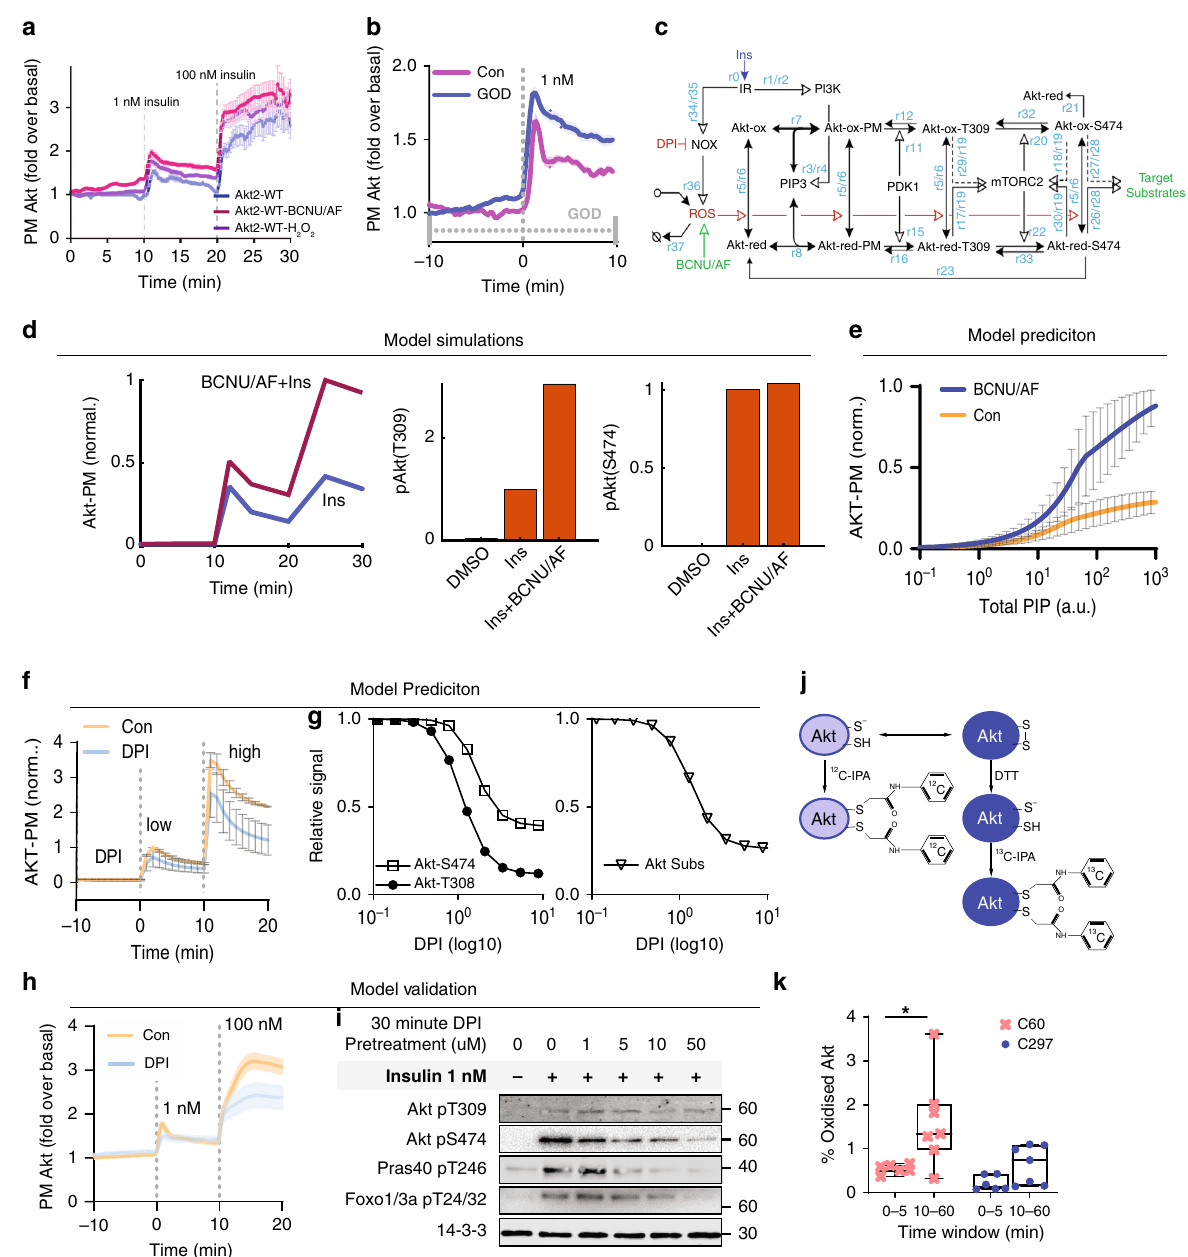
Fig. 7 A physiological role for C60 and C77. a , b TIRF imaging of adipocytes overexpressing TagRFPt-Akt2-WT treated with a BCNU/AF or H 2 O 2 (100 µ M) or b glucose oxidase (GOD) as indicated prior to stimulation with 1 nM insulin. Data are mean ± SEM. c The simpli fi ed mechanistic AKT oxidation-